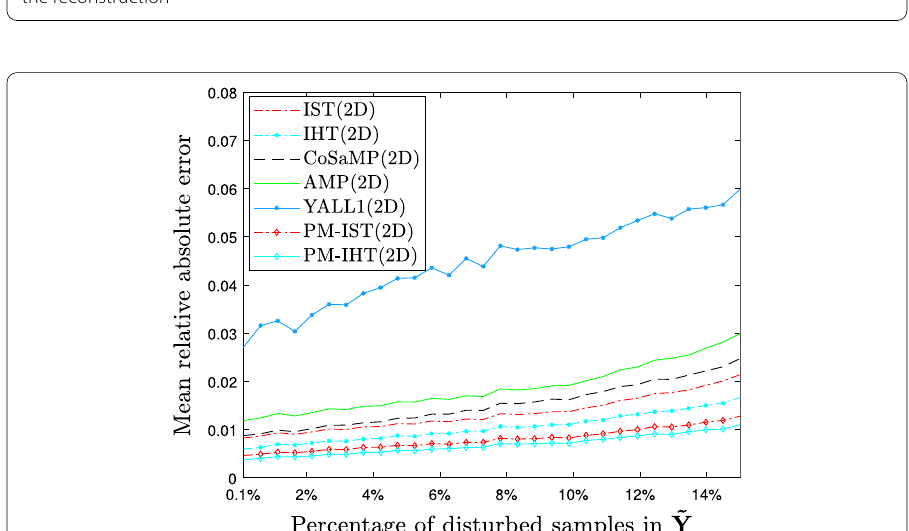
Fig. 9 Mean relative absolute error of 2D algorithms vs. percentage of interference-contaminated samples used in the